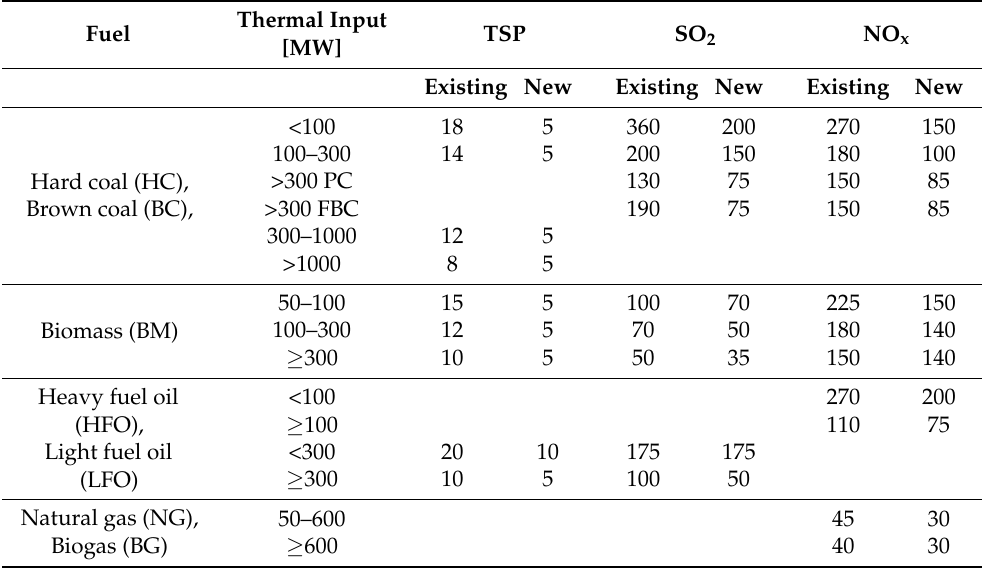
Table 2. The average annual emission limits of pollutants according to BAT conclusions (mg/Nm)